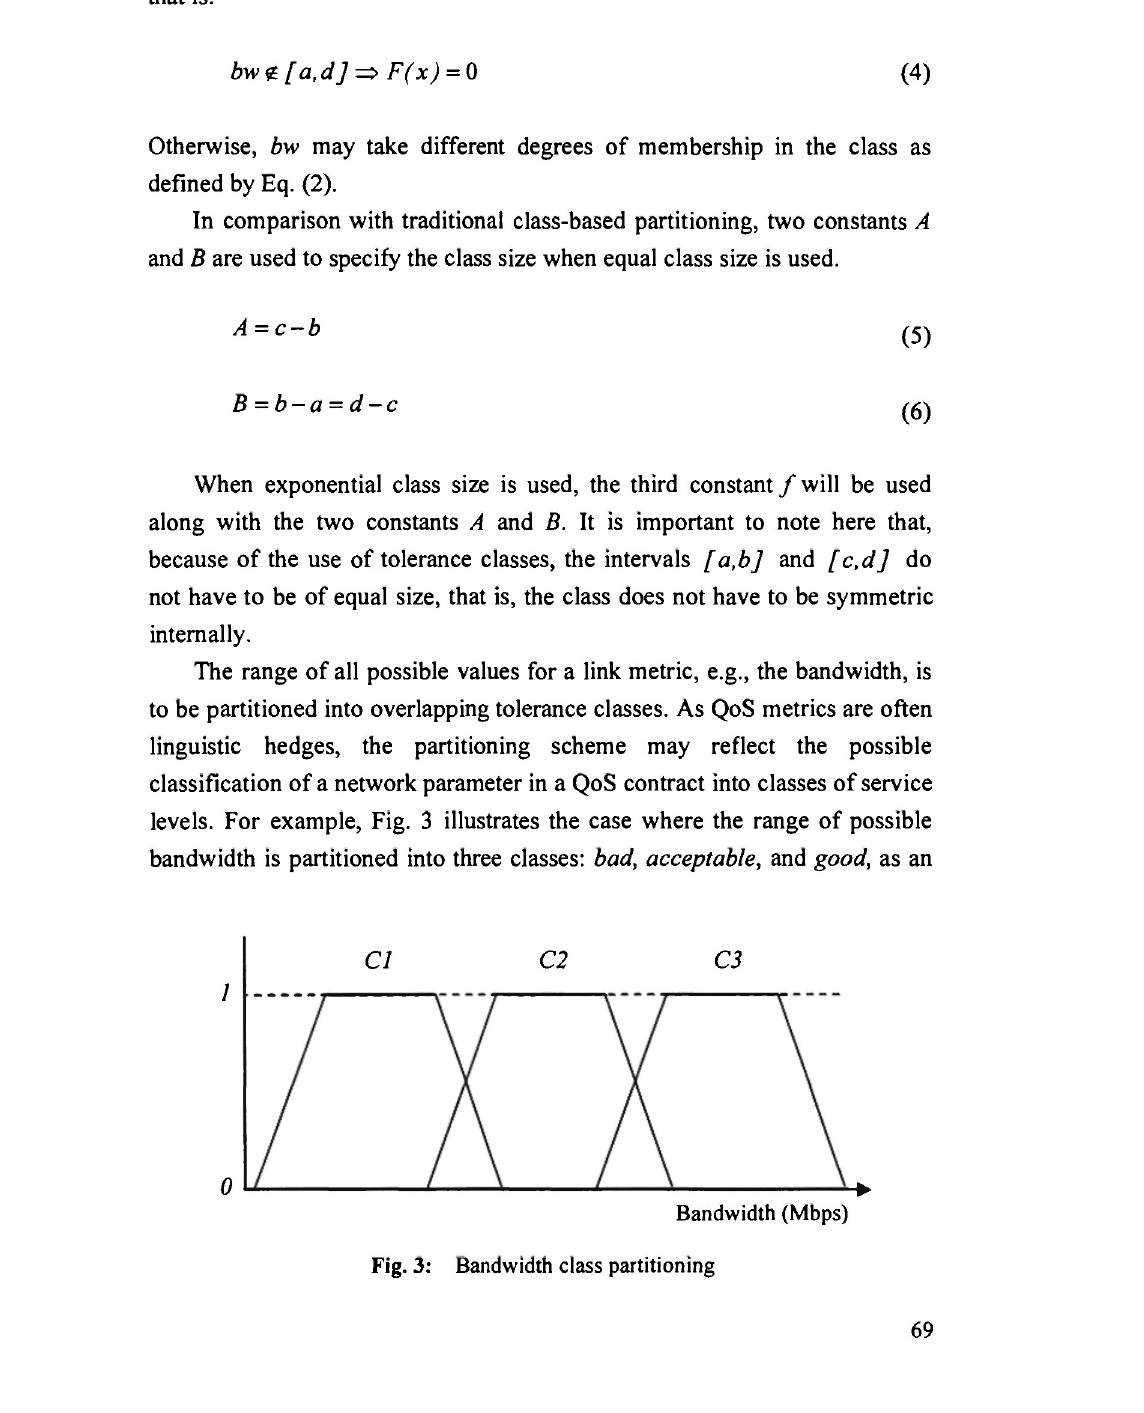
Fig. 3: Bandwidth class